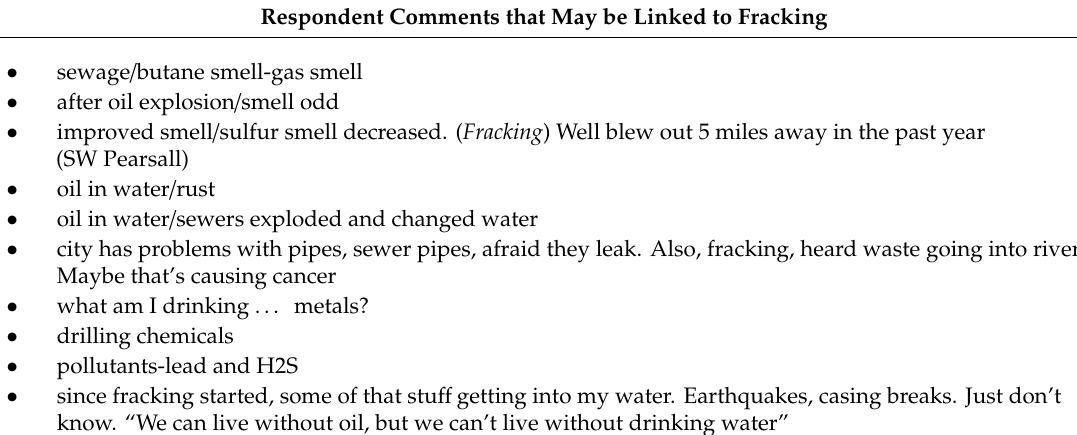
Table 2. Qualitative responses likely associated with fracking activities without spelling